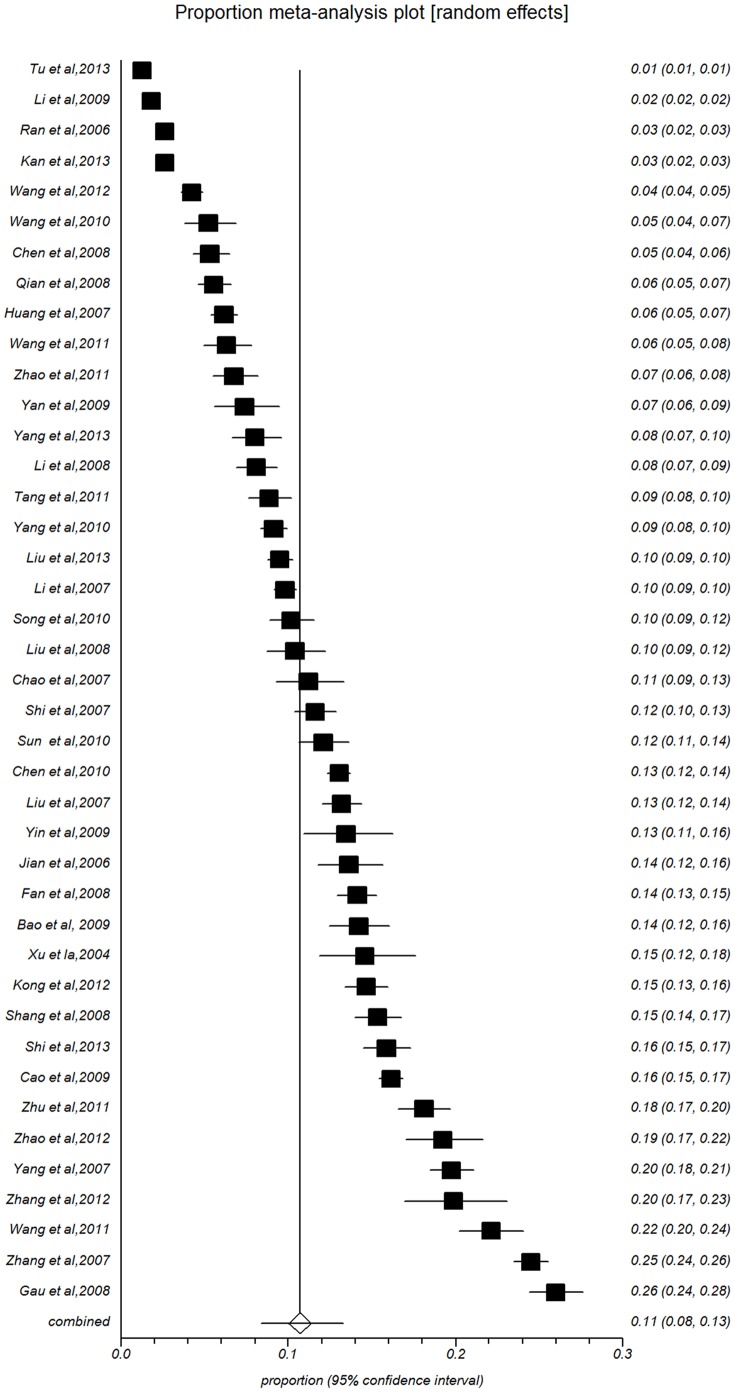
Forest plot of prevalence of suicidal ideation for total people.